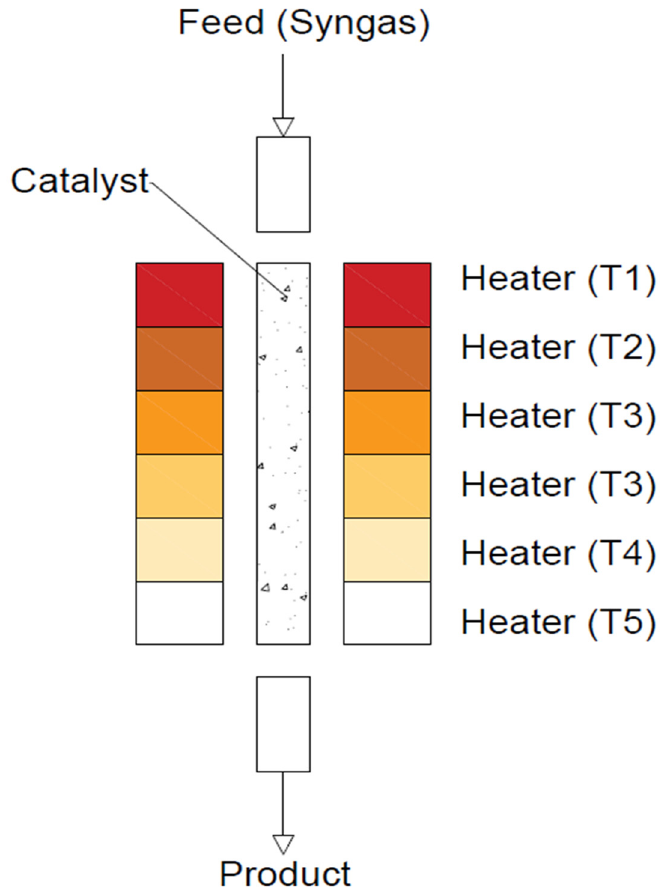
Figure 18. Scheme of a temperature-gradient reactor. Developed based on [93]